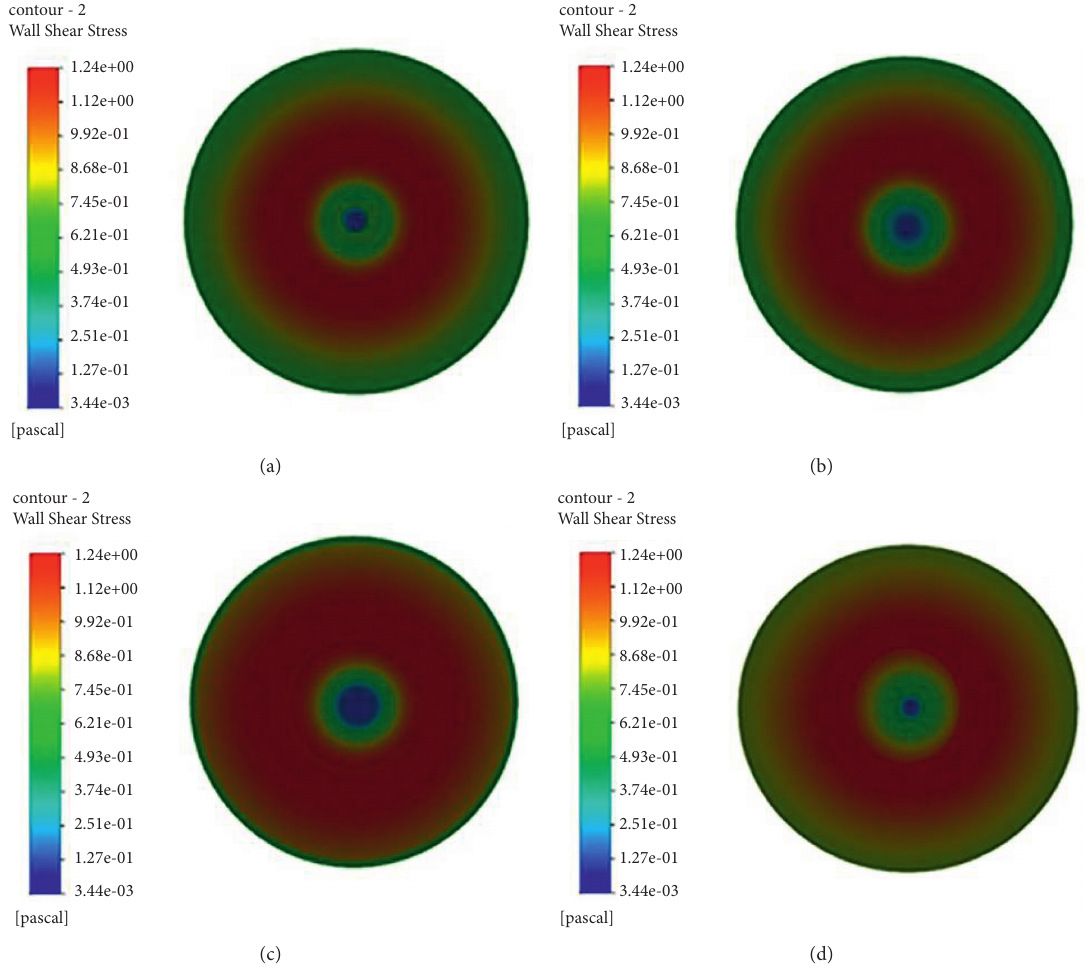
Figure 3: The results of shear stress distribution on the blade surface with different blasting pressures. (a) The shear stress distribution with the blasting pressure of 0.5MPa. (b) The shear stress distribution with the blasting pressure of 0.6MPa. (c) The shear stress distribution with the blasting pressure of 0.7MPa. (d) The shear stress distribution with the blasting pressure of